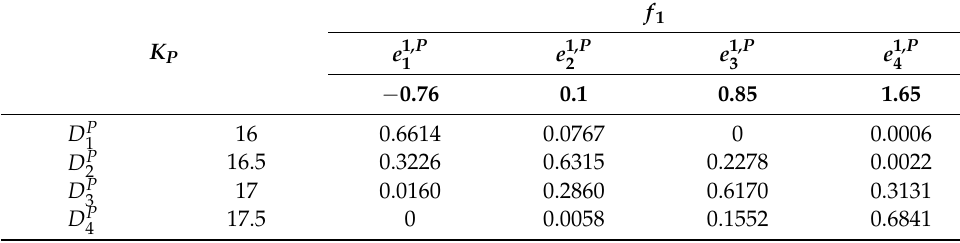
Table 8. IREM P of the input f 1